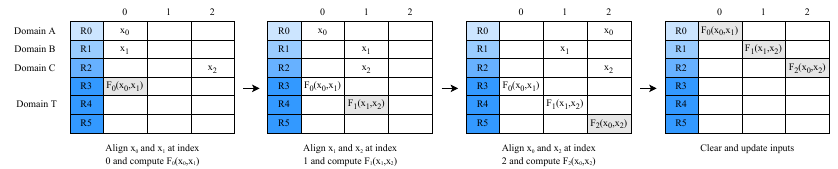
Figure 3: Methodology for td + 1 shares. In this masking, registers R0, R1, R2 belong to domain A, B and C respectively and R3-R5 are temporary registers in domain